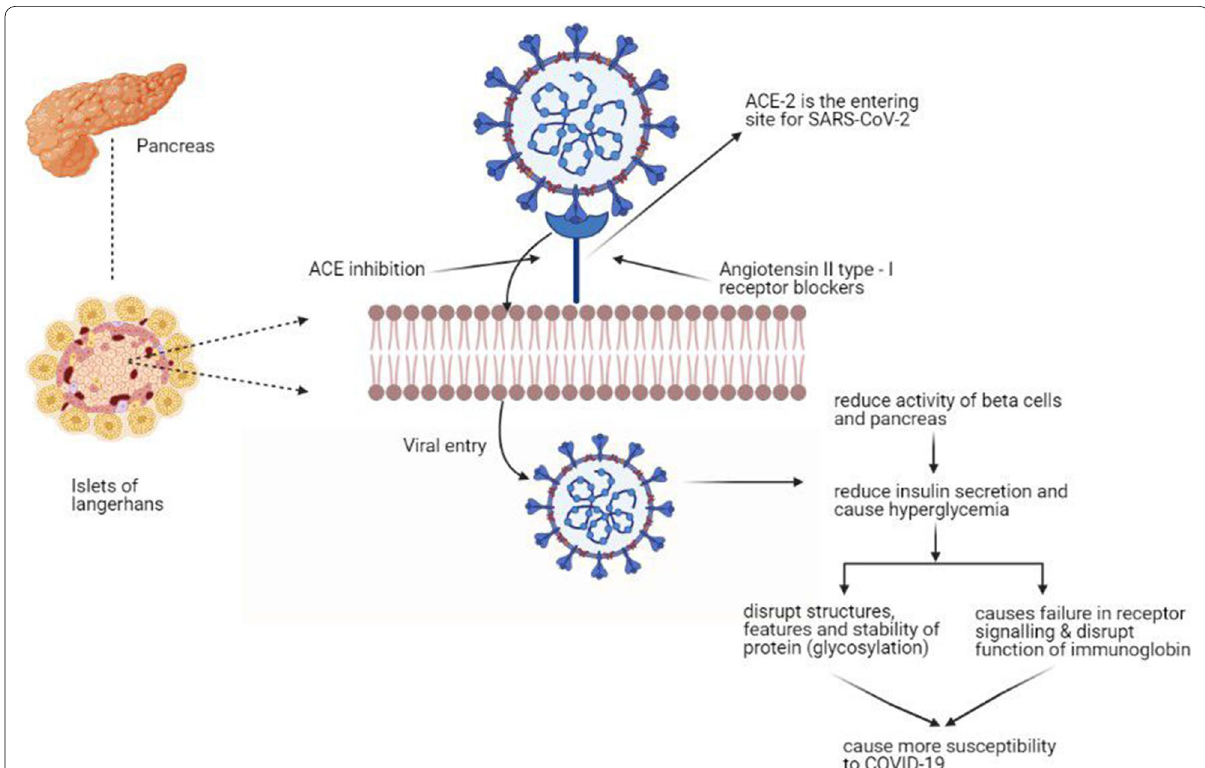
Fig. 1 Mechanisms of diabetes worsening COVID‑19